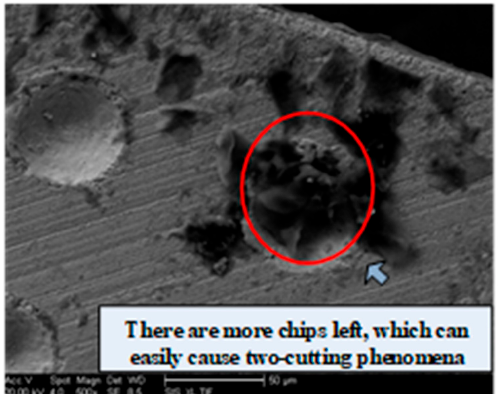
Figure 6. SEM image for a micro ‐ pit with a diameter of 60 μ m.